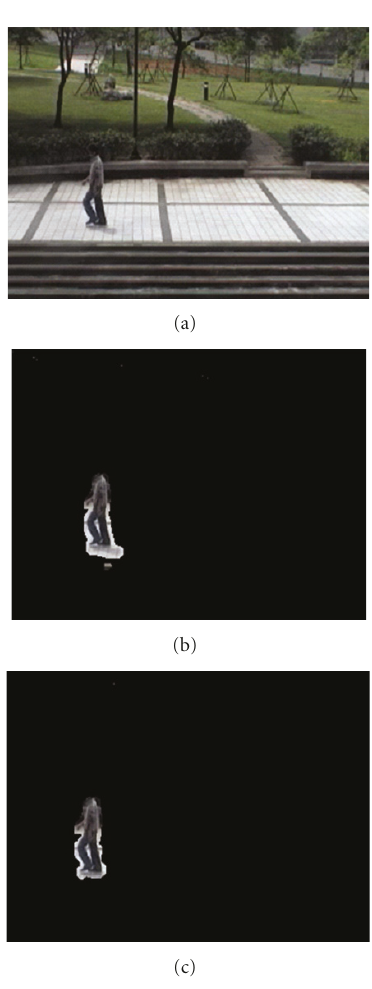
Figure 3: The results in shadow elimination, (a) the original image, (b) the extracted object before shadow elimination, (c) the extracted object after shadow elimination.